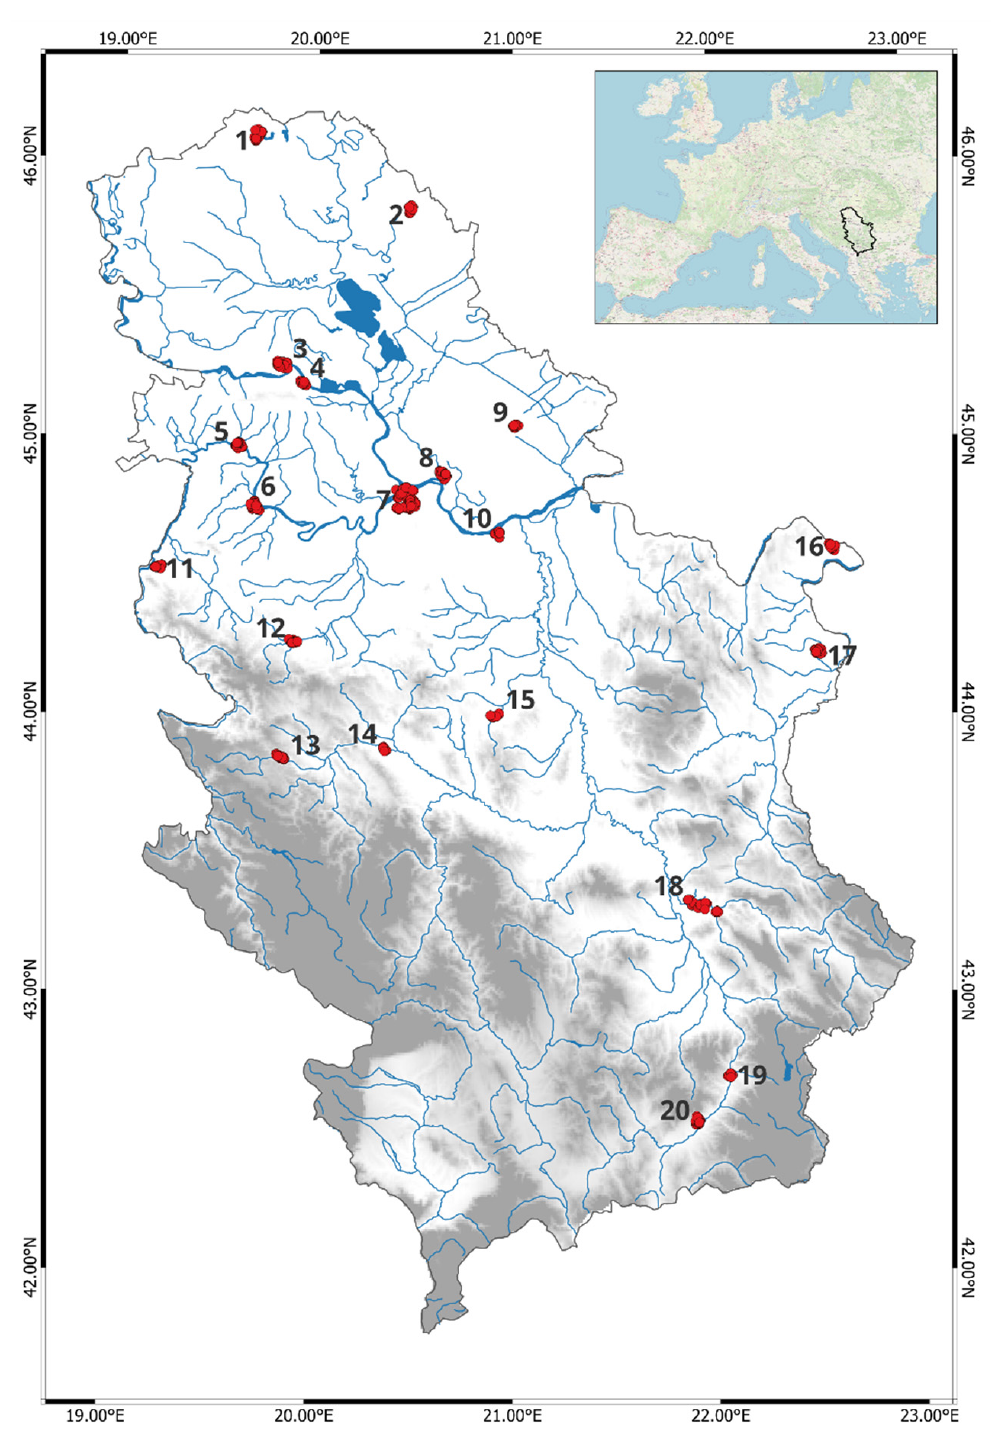
Figure 1. Locations of the investigated cities. 1—Subotica; 2—Kikinda, 3—Novi Sad;